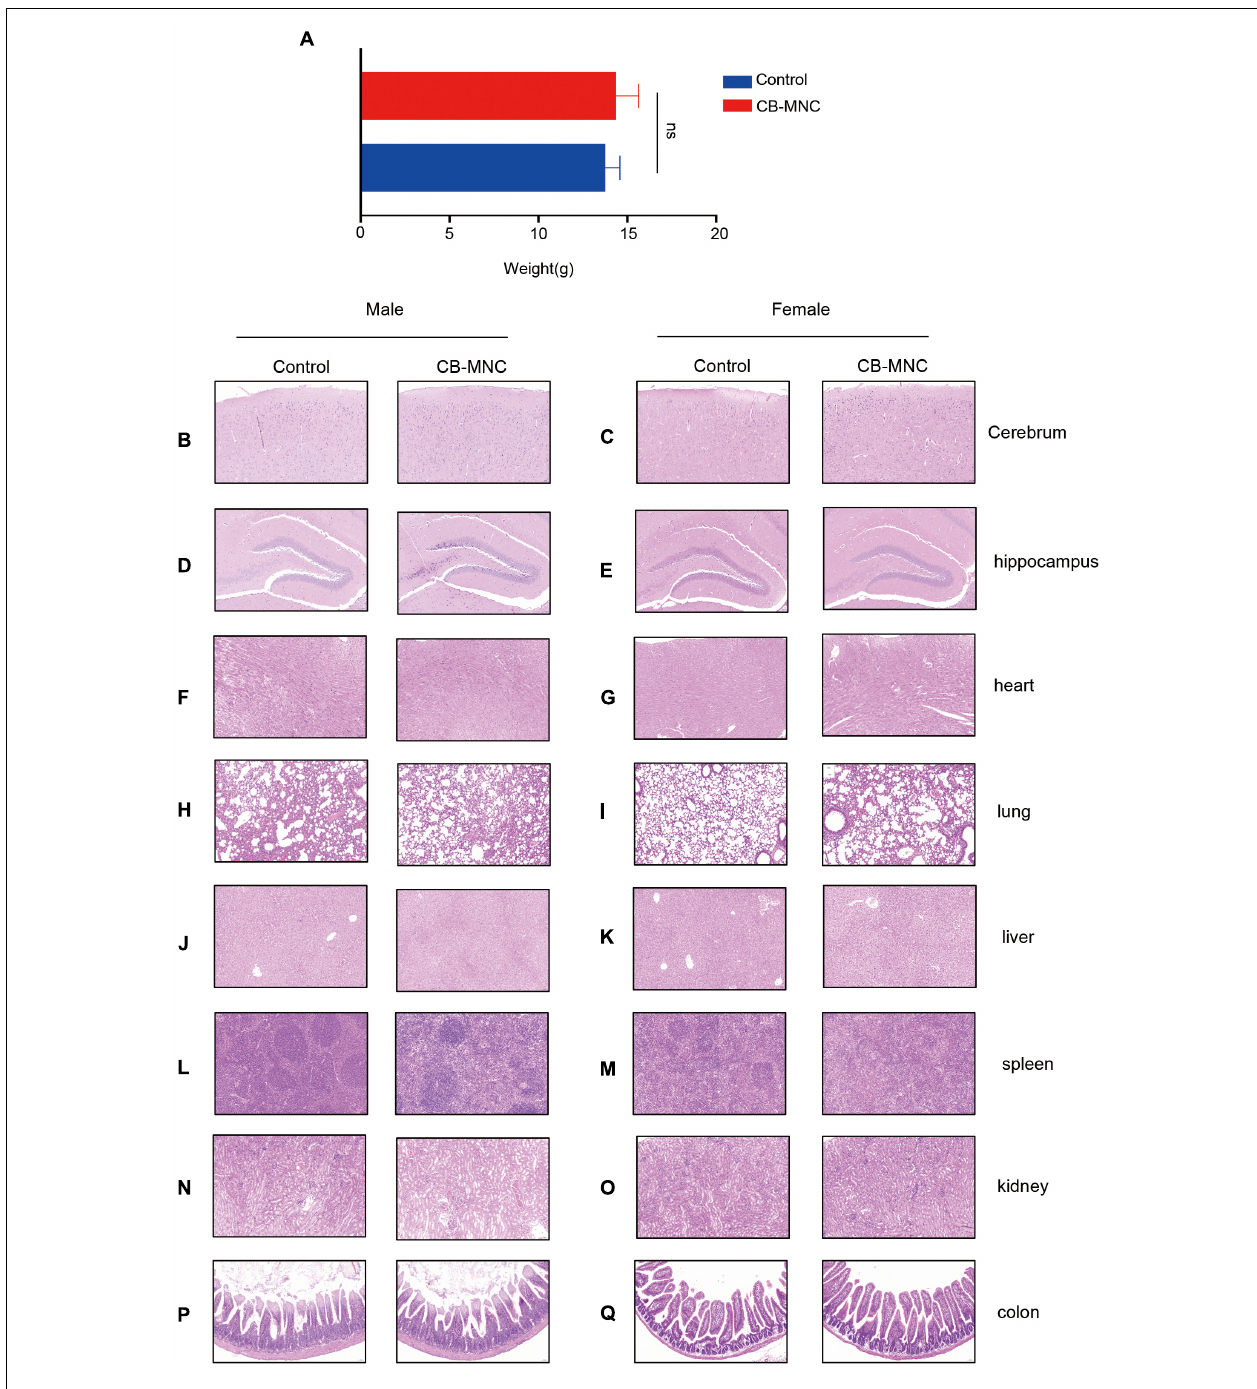
FIGURE 6 | General report of pathology regarding toxicity test. Mice in control group and mononuclear cell (MNC) group [intravenous infusion 3 × 10 6 cell/kg initiated at postnatal day (PN)7, twice in total] were sacrificed at PN28. Body weight was monitored (A) . At the end of the euthanasia infusion, neither cord blood-derived mononuclear cell (CB-MNC)-infused male nor female mice displayed significant abnormal changes in brain (B–E) , heart (F,G) , lung (H,I) , liver (J,K) , spleen (L,M) , kidney (N,O) , and colon tissues (P,Q) . Scale bar: 50 µ